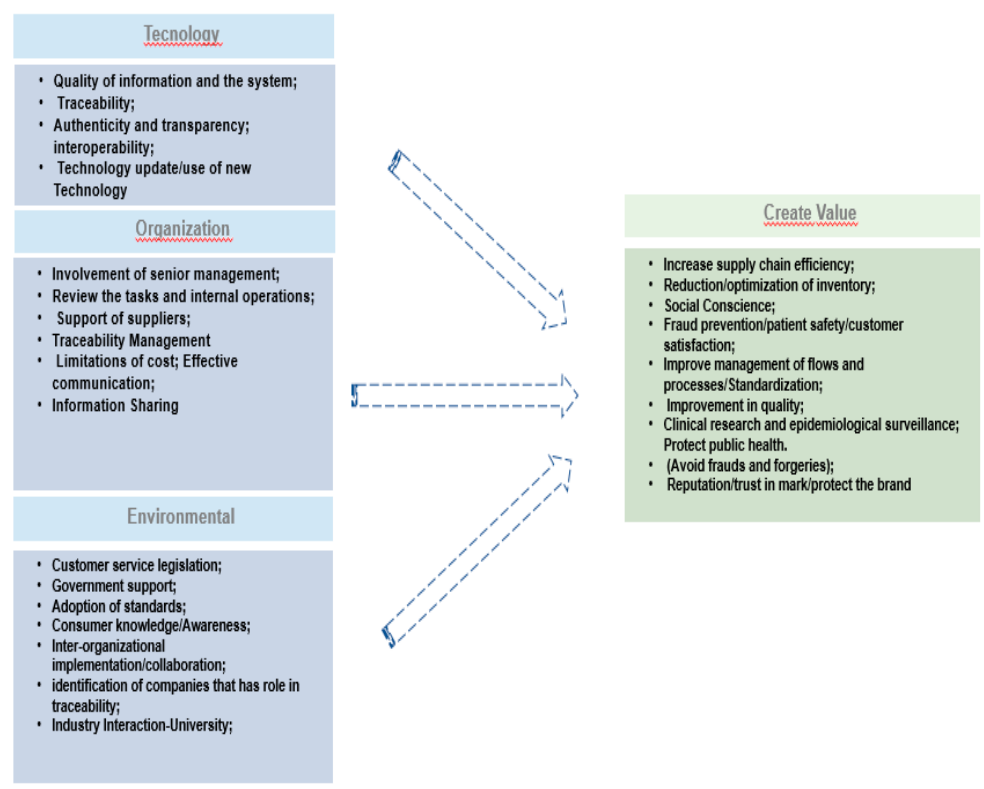
Figure 2. Research framework of the critical success factors for a drug traceability system (adapted from [31]).